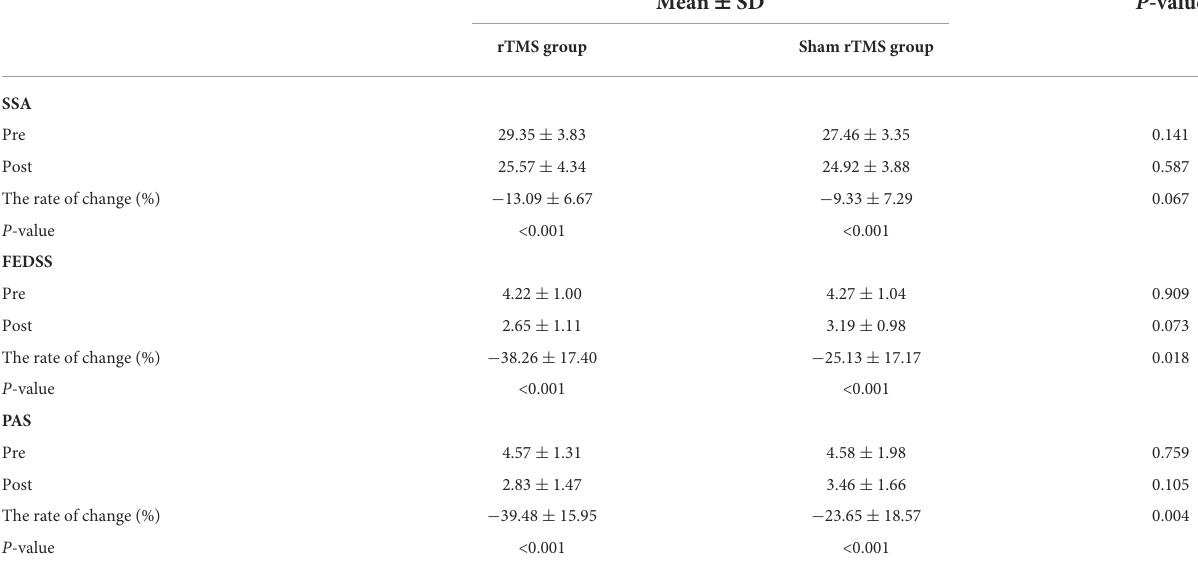
TABLE 2 The intergroup comparisons of clinical scale scores after the intervention, the intragroup comparisons of clinical scale scores for each group, and intergroup comparisons of the rate of change in clinical scale scores after